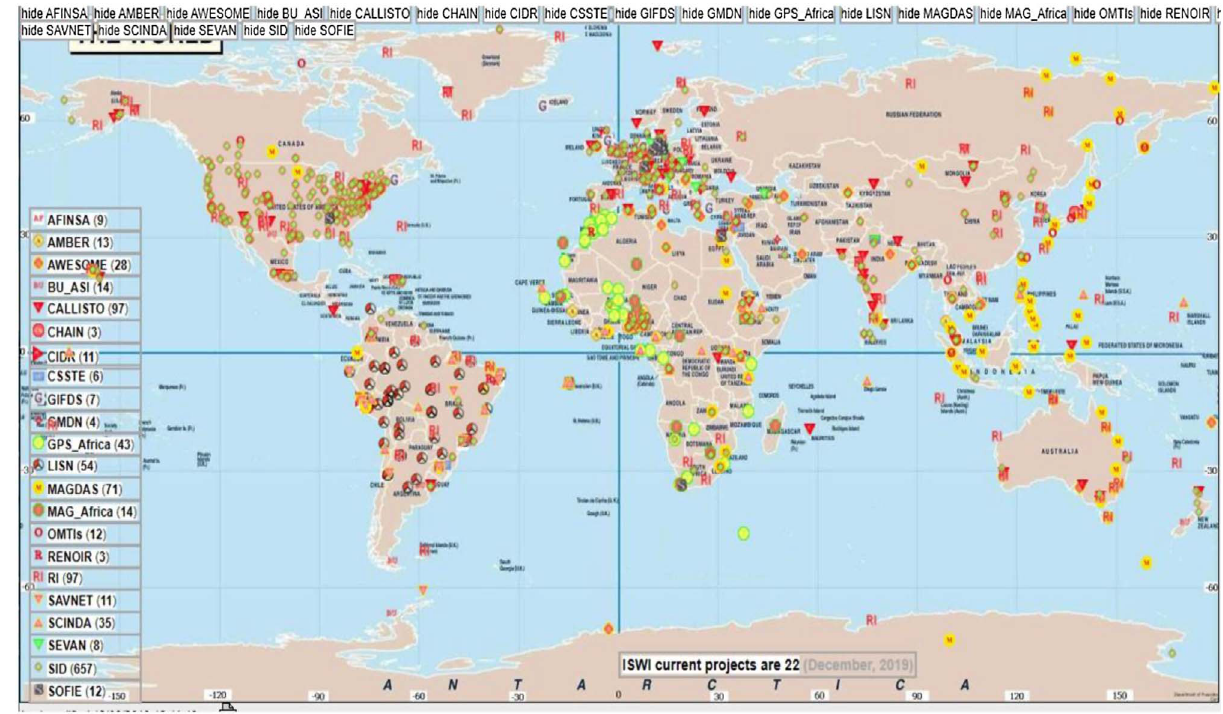
Fig. 2. ISWI instruments, map from